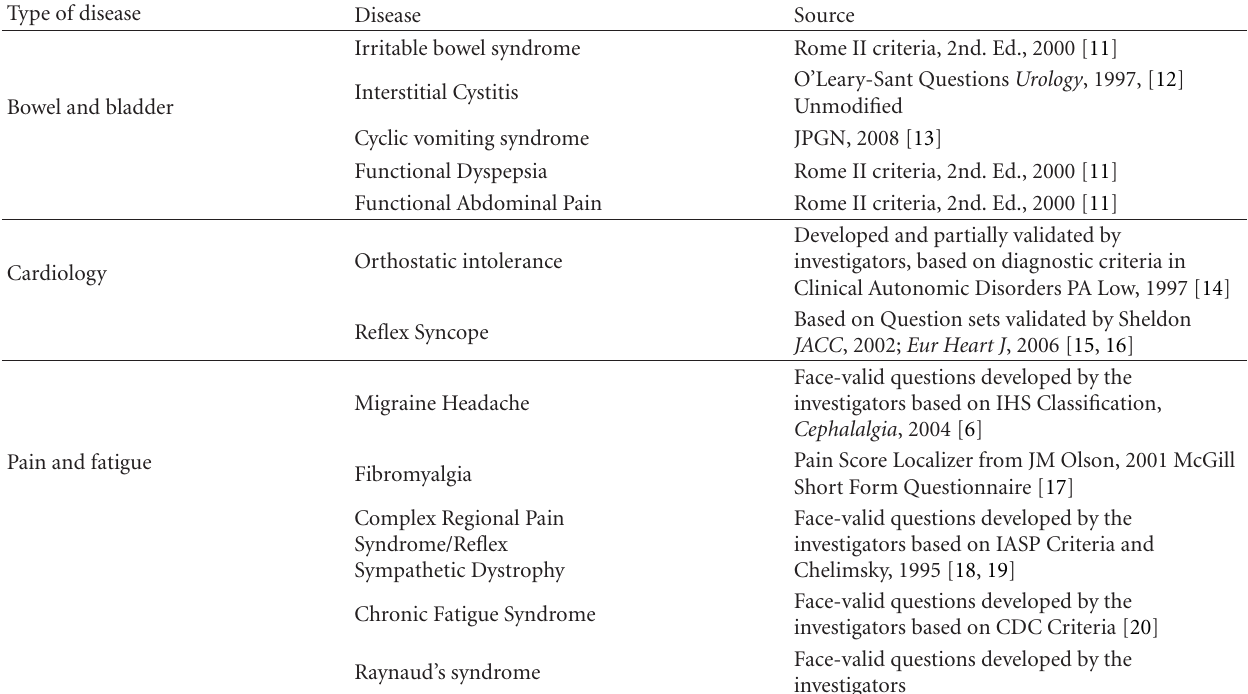
Table 1: Inclusion Criteria. This table shows the source of the adapted inclusion criteria for the comorbidities mentioned in ODYSA